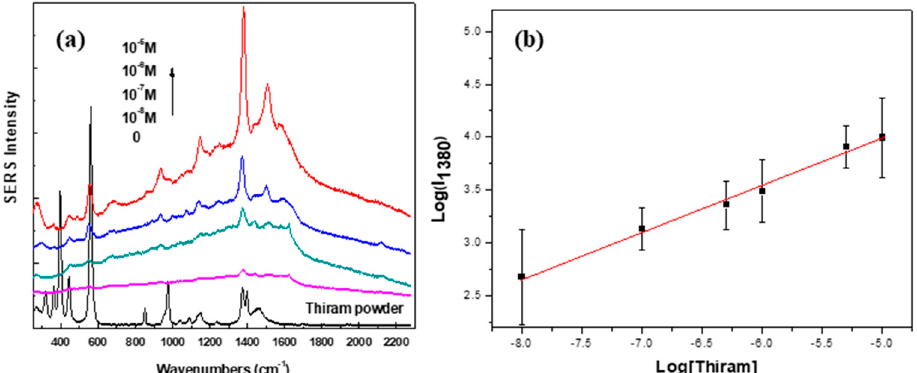
Figure 8. ( a ) SERS spectra of thiram, in solutions of various concentrations on Fe 3-x O 4 -Au NSs; ( b ) plot of log of SERS intensity at 1380 cm − 1 as a function of log of thiram concentrations in diluted water. Each point in the plot represents the average value of three random measurements on γ -Fe 2 O 3 -Au NSs. Errors bars correspond to standard deviations from these 3 experiments. The red line is the linear fitting curve based on the average values. Slope (0.43 ± 0.01); intercept (6.12 ± 0.12); R 2 = 0.99.